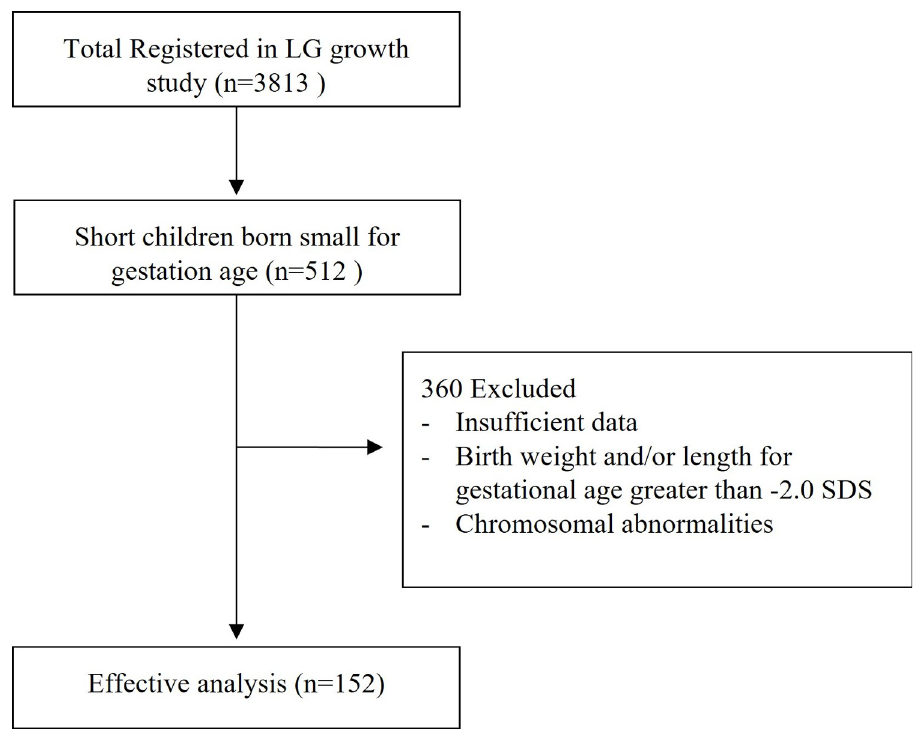
Fig 1. Flow chart of study